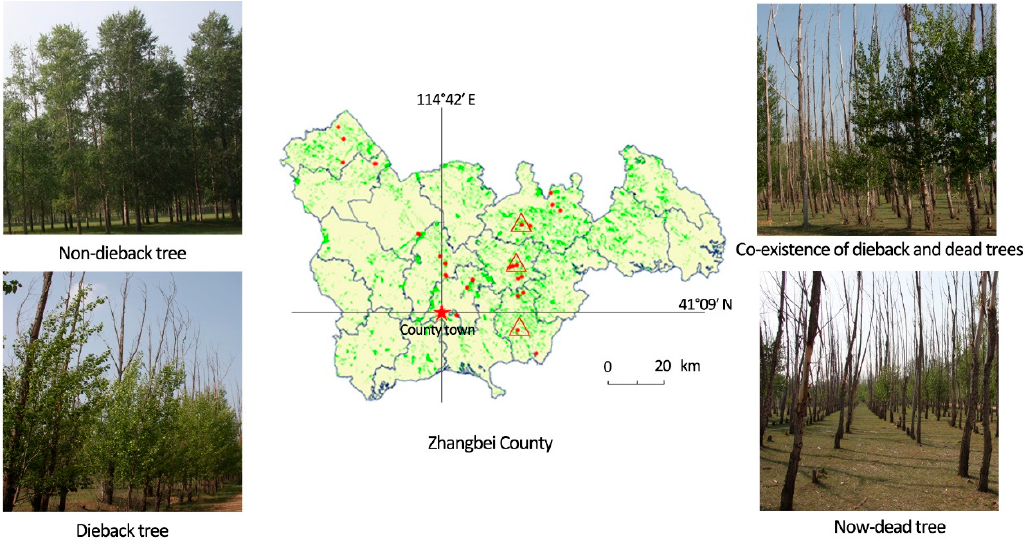
Figure 1. Location of Three-North Shelter Forest and experimental sites in Zhangbei County, Hebei Province, China. Red dots: sampling sites for analysis of relationship between poplar growth and dieback. Triangles: sampling sites for analysis of tree rings and carbon isotopes. Red star: County town.